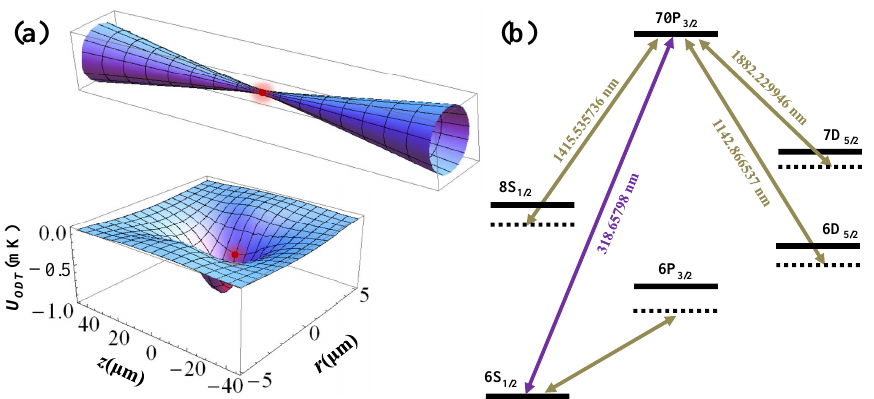
Figure 6. ( a ) A magic ODT formed by a strongly focused single-mode Gaussian laser beam. ( b ) The involved energy level diagram of magic ODTs for the 6 S 1/2 ↔ 70 P 3/2 single-photon transition coupled by a 318.65798 nm ultra-violet laser. The brown double arrow lines are auxiliary transitions from 70 P 3/2 to 7 D 5/2 , 8 S 1/2 , and 6 D 5/2 , and the corresponding magic wavelengths are 1882.229946, 1415.535736, and 1142.866537 nm,